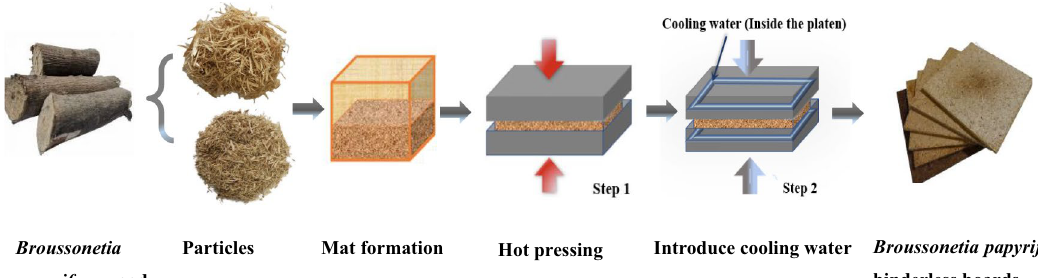
Fig. 2 Preparation route of Broussonetia papyrifera binderless